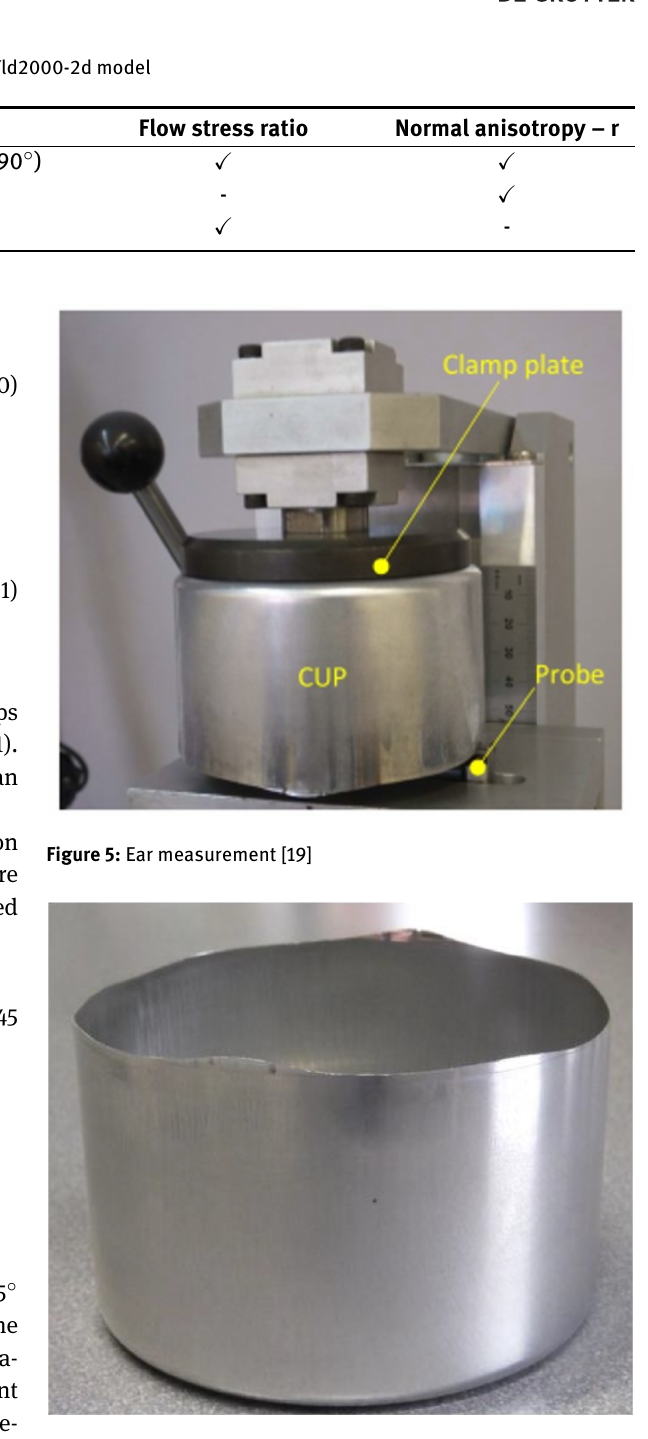
Figure 6: Ear creation on aluminium cup [19]